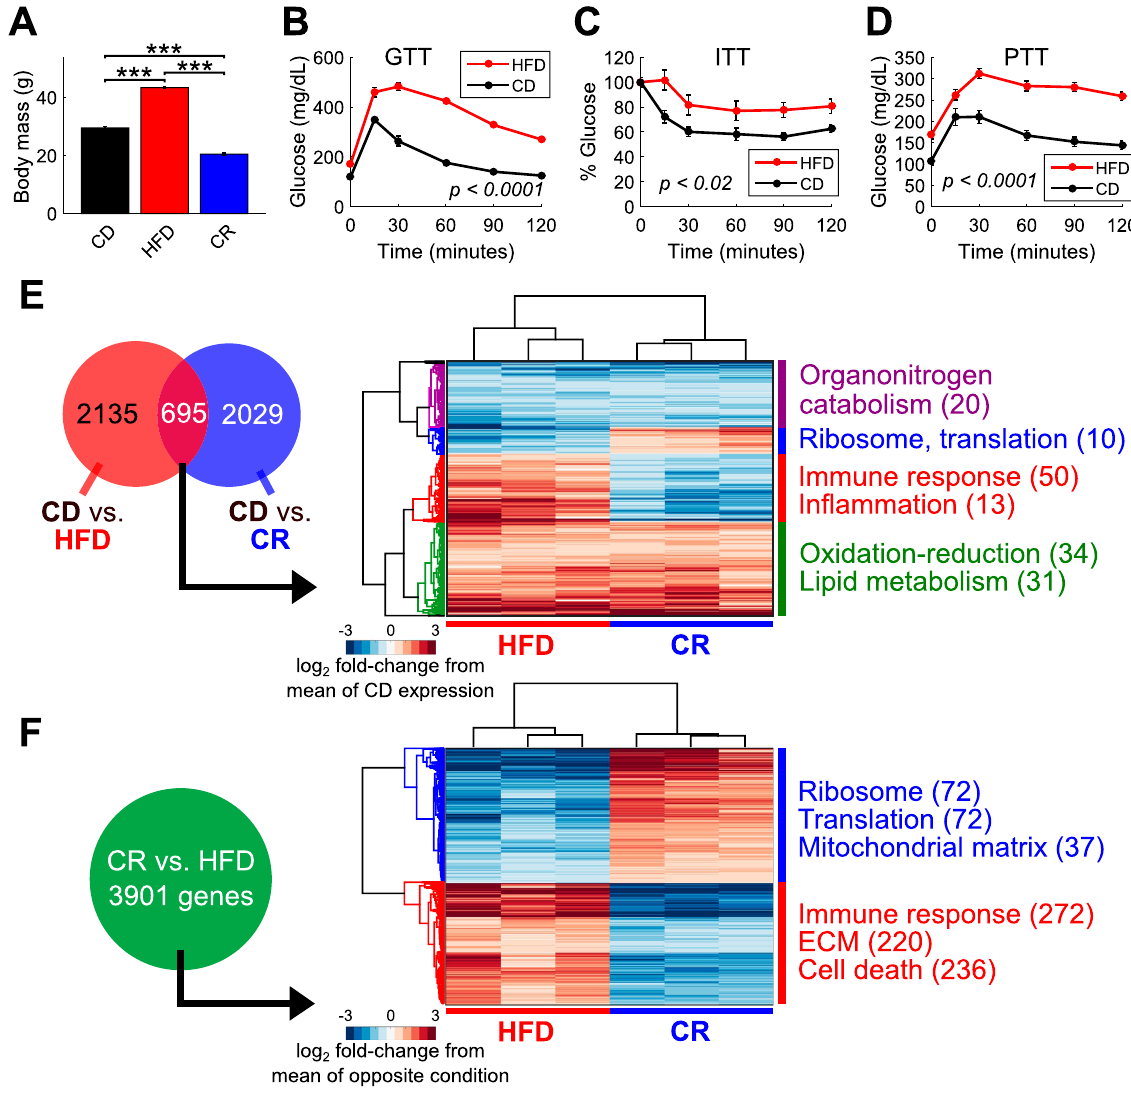
Figure 1. High-fat diet and calorie restriction alter body mass and induce extensive hepatic transcriptional changes. ( A ) HFD and CR feeding increase and decrease overall mouse body mass, respectively, compared to CD (n = 12, 10, and 12 for CD, HFD, and CR, *** p < 5e-5, two-sided t-tests). ( B–D ) HFD induces insulin resistance and alters glycemic regulation as assessed by ( B ) glucose tolerance test (GTT), ( C ) insulin tolerance test (ITT), and ( D ) pyruvate tolerance test (PTT) ( p -values from t-tests of area under the curve measurements, n = 30, 25, and 23 for CD and n = 37, 27, and 23 for HFD). ( E ) Venn diagrams show numbers of genes differentially expressed between CD and HFD livers (red circle) as well as CD and CR livers (blue circle). The overlap region shows 695 genes that are differentially expressed in both CR and HFD compared to CD. The clustergram shows these 695 overlapping genes that are up-regulated by both HFD and CR (255 genes), down- regulated by both CR and HFD (183 genes), up-regulated in HFD and down-regulated by CR (186 genes), and up-regulated in CR but down-regulated in HFD (71 genes), along with gene ontology and pathway enrichment terms. The numbers indicate how many genes in each group that are annotated to each term. Values are log 2 fold-changes for individual replicate expression levels (in FPKM) versus the mean CD expression level. ( F ) 3,901 genes are differentially expressed between CR and HFD livers (green circle). The clustergram shows individual replicate gene expression levels as log 2 fold-change compared to the mean expression level for the opposite condition (CR or HFD). The numbers indicate how many genes in each group that are annotated to each